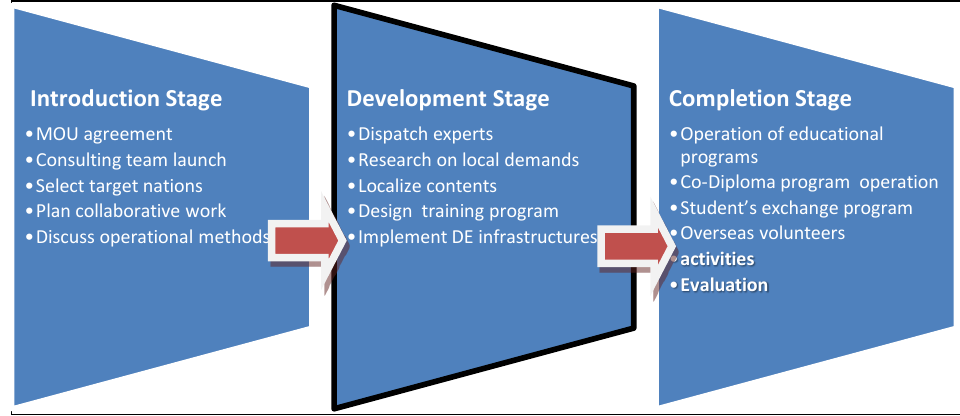
Figure 1 Phases of cooperation in the PCPD